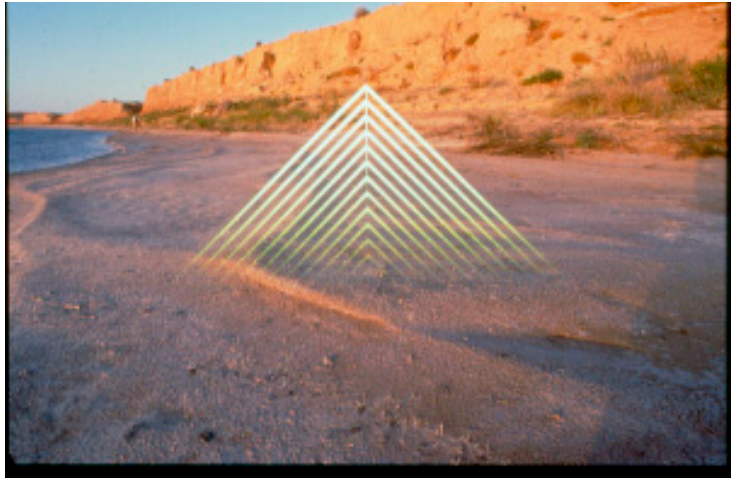
Figure 22. One of Ostoja’s landscapes with CGI. Published with permission. Image courtesy of the State Library of South Australia. SLSA: PRG 919/21/64.